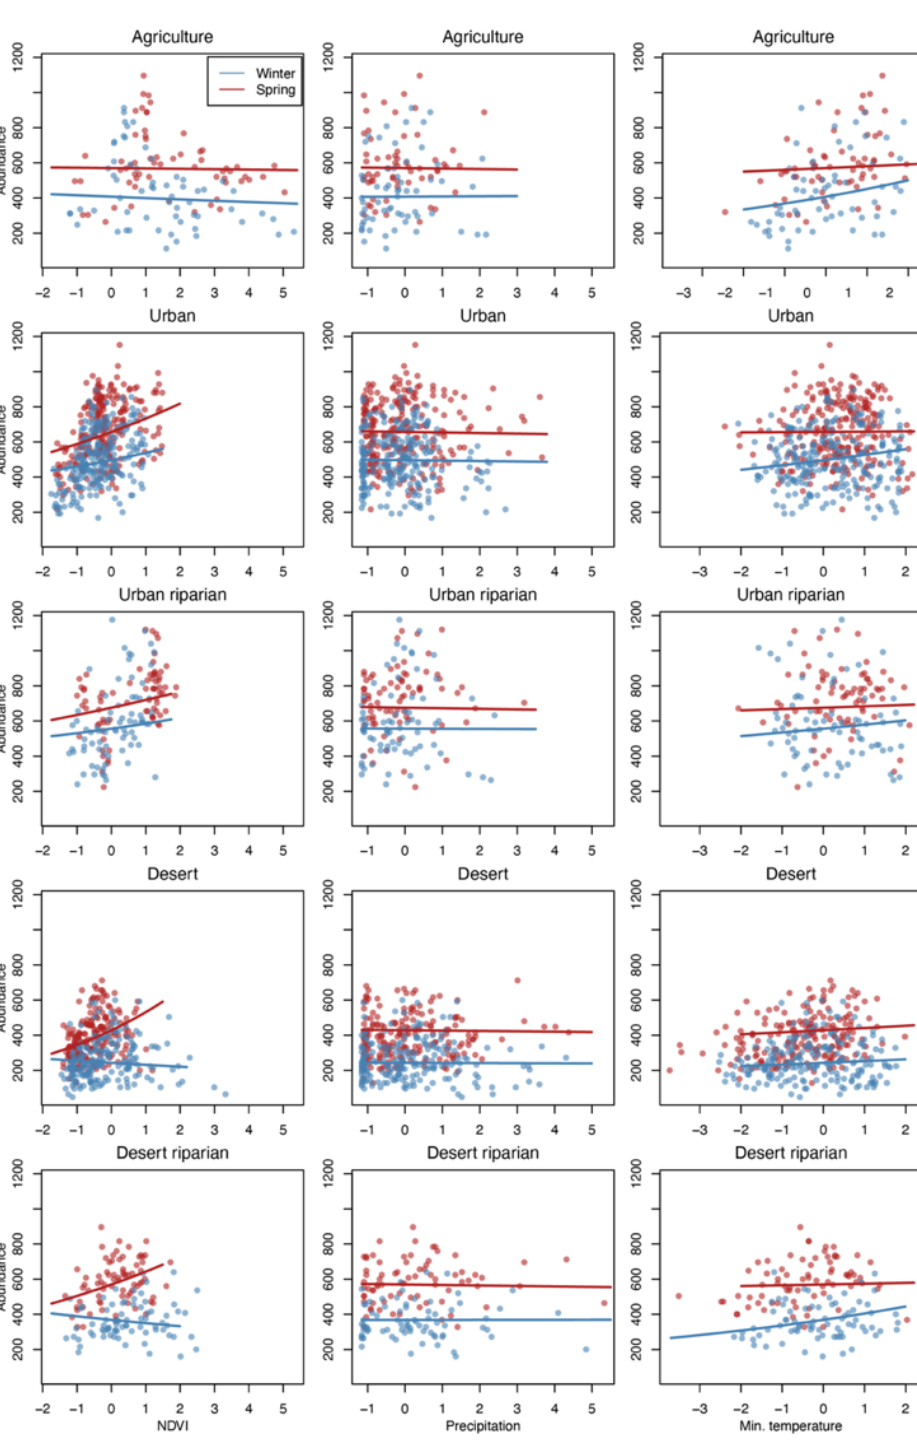
Figure 3. Scatterplots of avian abundance and environmental variables: NDVI (left column), pre- cipitation (middle column), and minimum temperature (right column). Graphics are organized by land-use type (rows). Lines represent the fit of the averaged generalized linear mixed models for avian abundance in spring (red) and winter (blue).